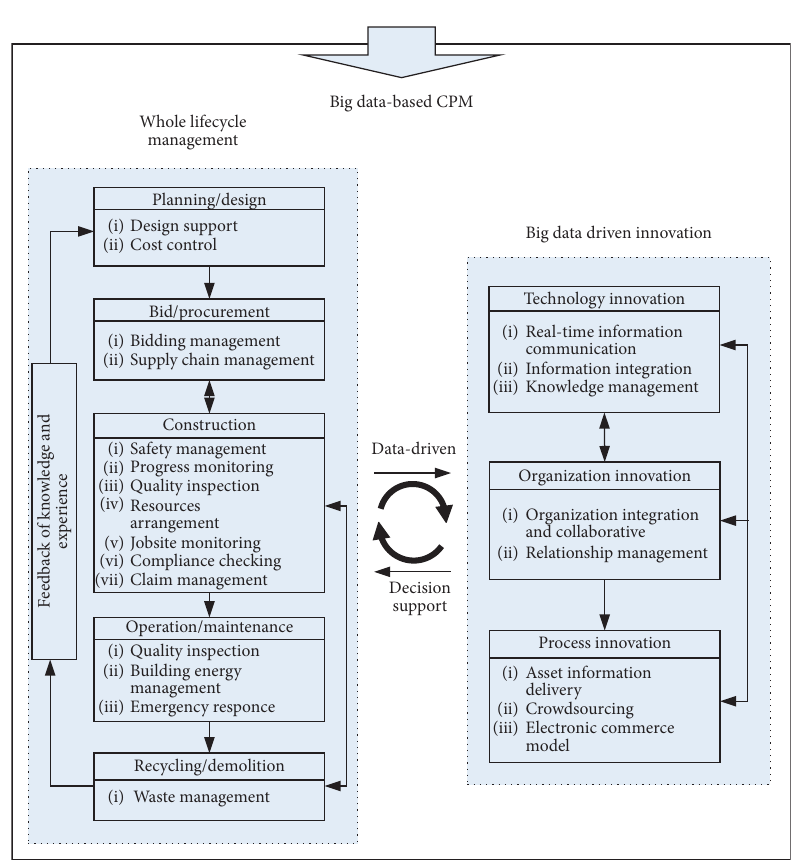
Figure 5: A comprehensive scenario of data-driven